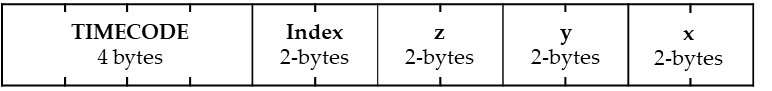
Figure 7. Structure of the 12-byte array representing a timestamped 3D inertial sample. Inertial data are buffered into arbitrarily sized 6 kB buffers, doubled to 12 kB as for audio data to implement an A/B approach as shown in Figure 8. At 50 Hz, accelerometer data fill a buffer every 6144/(12 × 50) = 10.24 s, triggering an SD write operation on 6144/512 = 12 sectors. Magnetometer data are written on the SD card every 6144/(12 × 10) = 51.2 s.